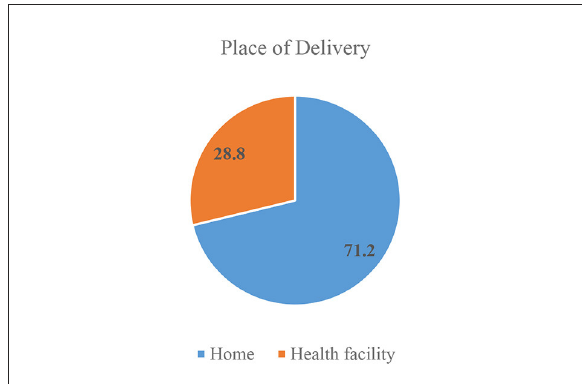
FIGURE1 Place of delivery among women who gave birth in the past 12 months in Mandura district, Benishangul Gumuz, Ethiopia, 2020 ( n =